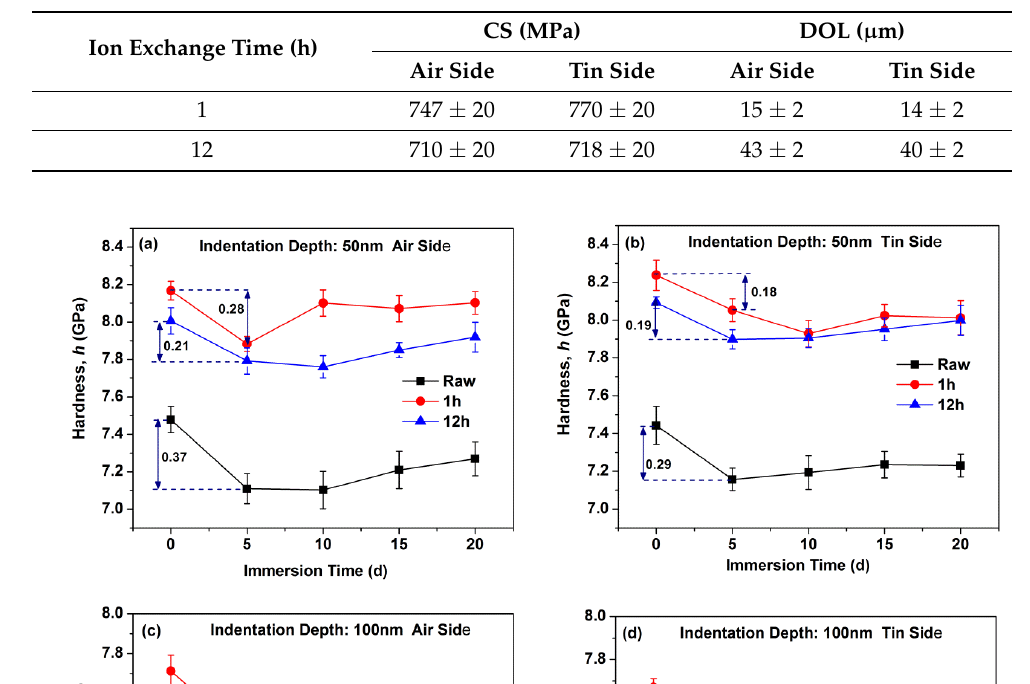
Table 2. CS and DOL of the ion-exchanged glasses.